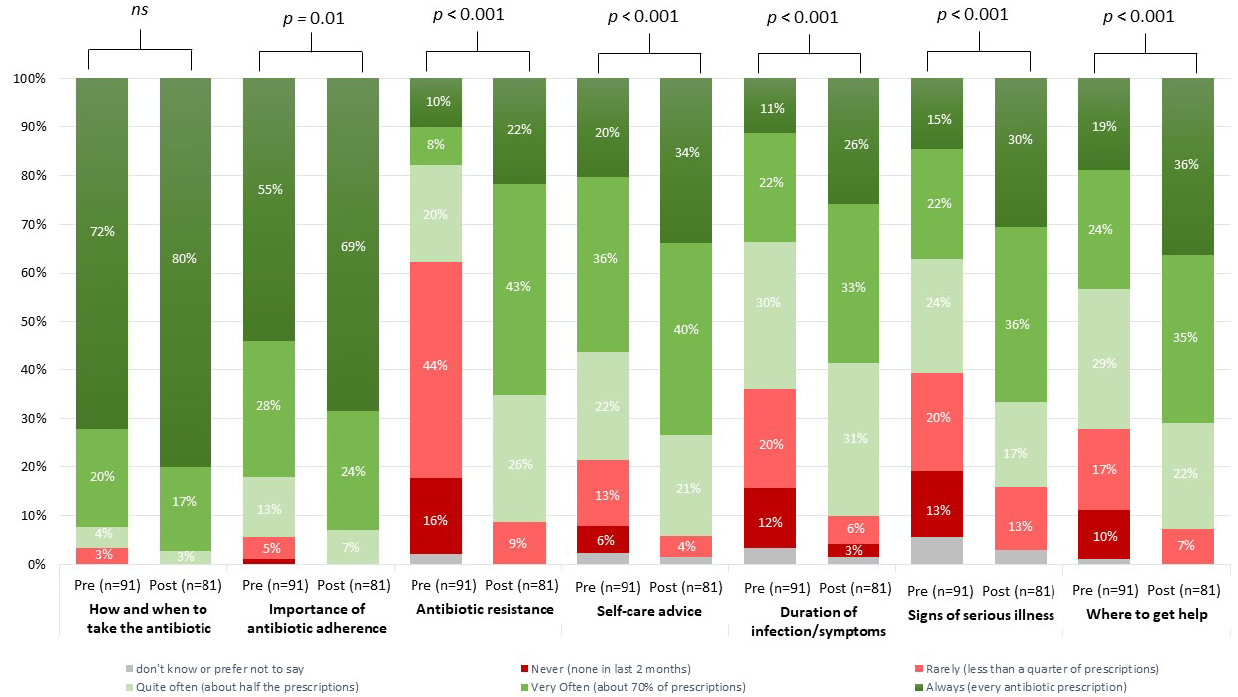
Figure 4. Community pharmacy staff provision of antibiotic and infection advice to patients, pre- and post-intervention. Pharmacy staff reported how often they provided advice to patients on their antibiotics and managing their infection. p signifies the strength of evidence from the statistical modelling, Ns signifies there is no significant evidence.